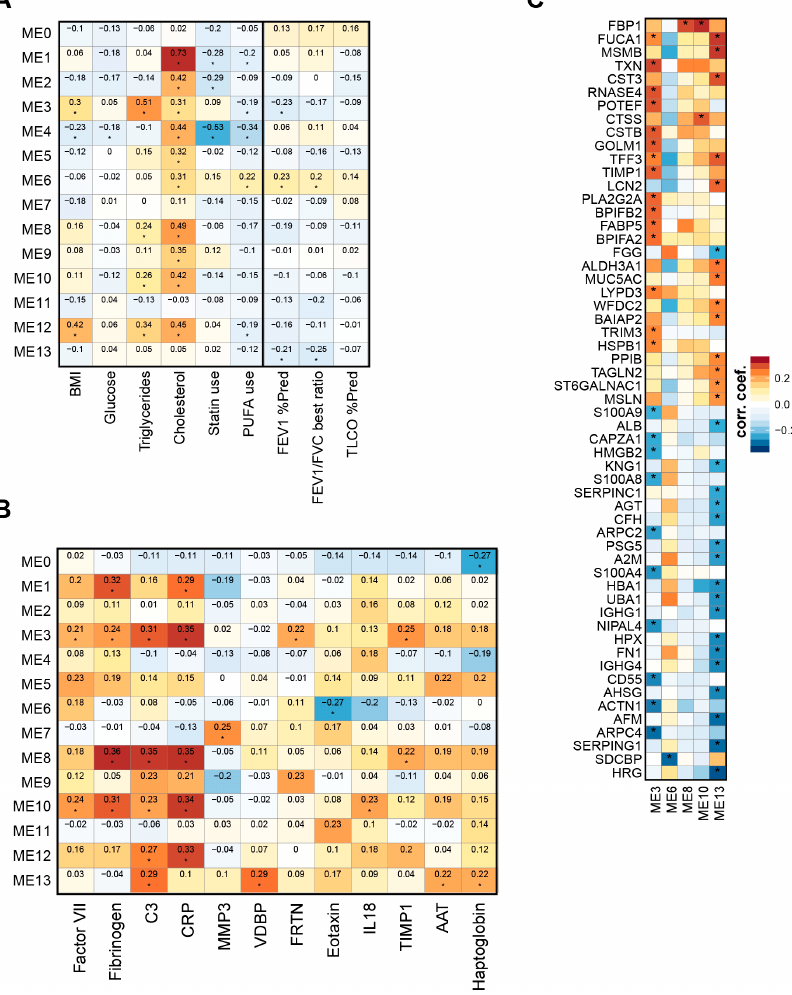
Figure 5. Lipid modules correlate with clinical parameters, blood markers, and sputum protein profiles. ( A ) Correlation between module eigenlipids and clinical measurements: body mass index (BMI), glucose, triacylglycerols, cholesterol measured in blood by clinical chemistry, lipid modifier use, and the lung function parameters forced FEV1 % Pred., FEV1/FVC best ratio, and transfer factor for carbon monoxide (T L CO) % Pred. Pearson correlation coefficients are shown (red: positive, blue: negative). Significant correlations with a FDR adjusted p -value <0.05 are marked (“*”); ( B ) correlation between module eigenlipids and plasma markers. The Pearson correlation coefficients are color-coded and statistically significant correlations with FDR adjusted p -values <0.05 are marked. Only markers with at least one significant correlation are included. For the correlation, the measured marker values/concentrations were log-transformed. See Table S3 for the group comparison results for these markers. C3, complement factor C3; CRP, C-reactive protein; VDBP, vitamin D-binding protein; FRTN, ferritin; AAT, alpha-1-antitrypsin; ( C ) Correlation between module eigenlipids and protein expression profiles in induced sputum [8]. Protein labels are the official symbols of the respective genes (www.genenames.org) [30]. The Pearson correlation coefficients are color-coded and statistically significant correlations with FDR adjusted p -values <0.05 are marked (“*”). Only module eigenlipids with at least one significant correlation are